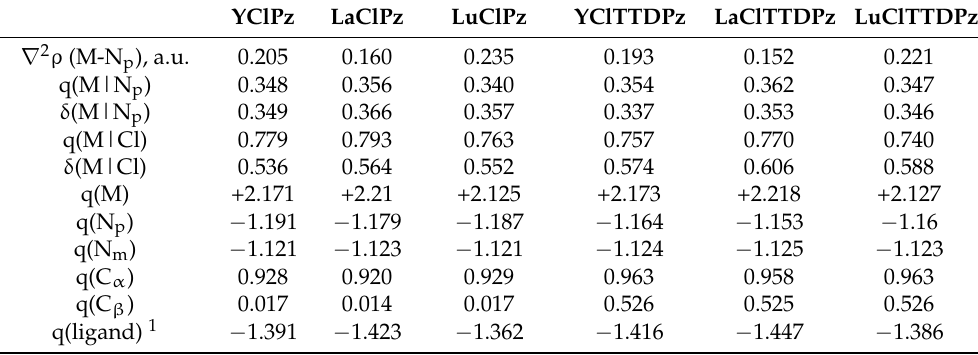
Table 2. Selected parameters of MClPz and MClTTDPz complexes from quantum theory of atoms in molecules (QTAIM)